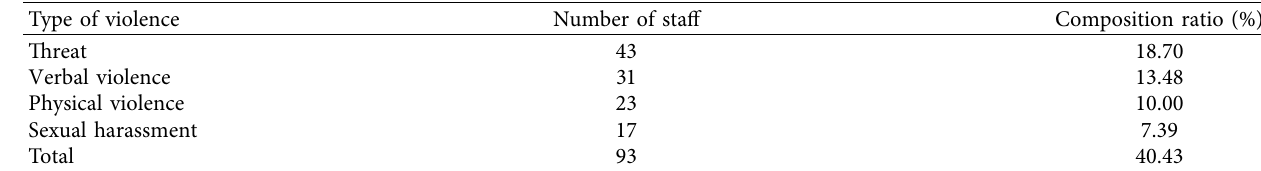
Table 1: Workplace violence suffered by ICU medical